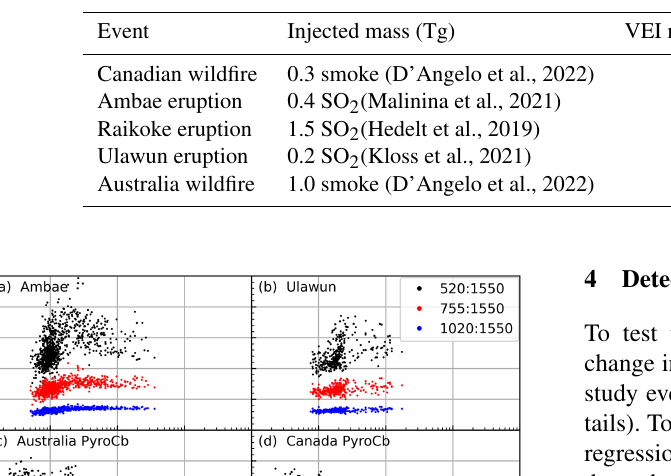
Table 2. Listing of major events used in the current study. All events used data collected between 14 and 25km. Injected masses refer to the estimated upper limit of total injected mass for each event (not just the mass injected between 14 and 25km). The VEI rating is not applicable (NA) to wildfire events.